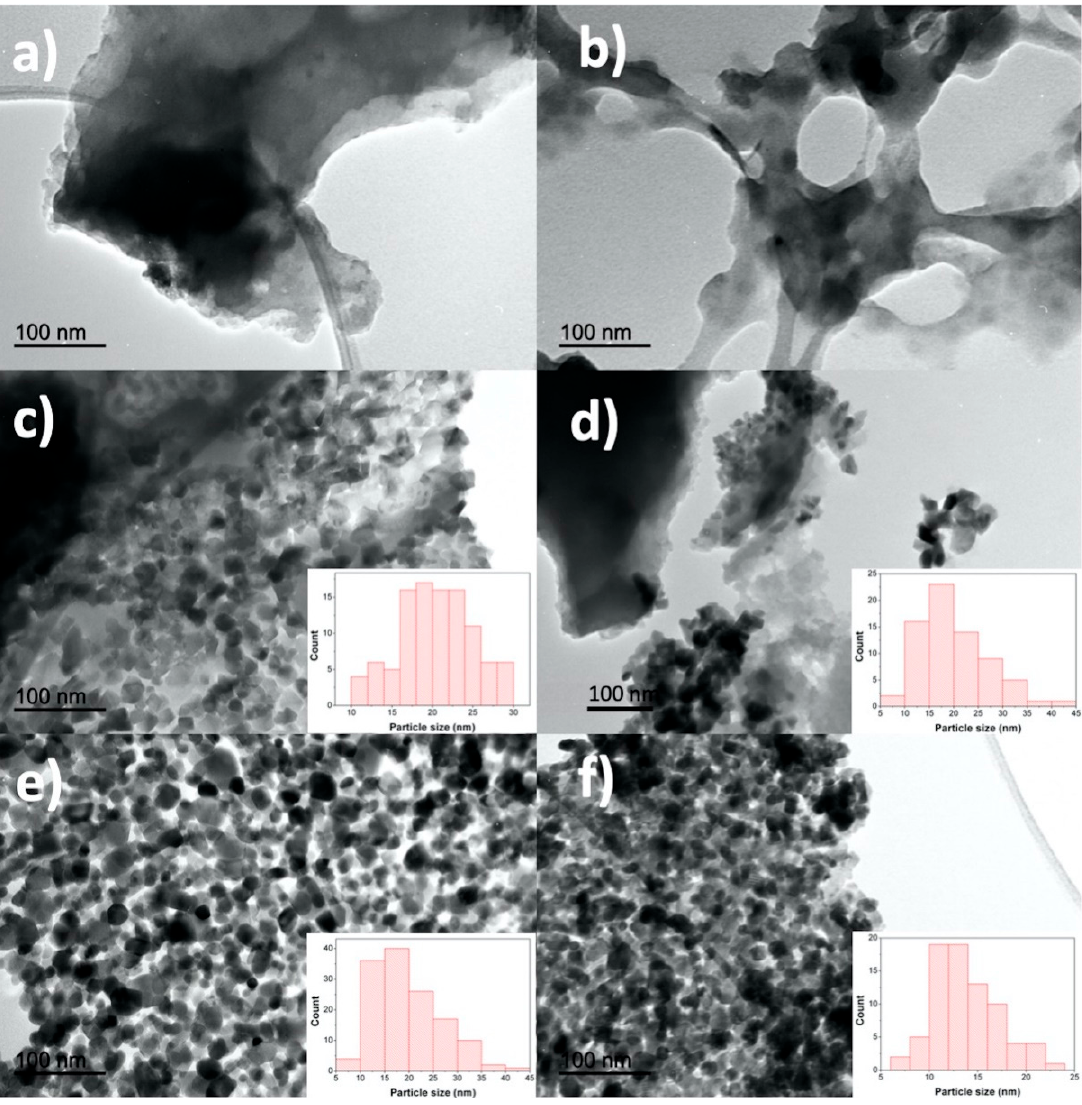
Figure 4. TEM images for the representative samples ( a ) PAN-A, ( b ) PAN-N, ( c )PAN-A/3%Co, ( d ) PAN-N/3%Co, ( e ) PAN-A/10%Co and ( f ) PAN-N/10%Co. The inset ( c – f ) shows the particles size distribution. The total electrode activity was determined by the total number of active sites [36,46].